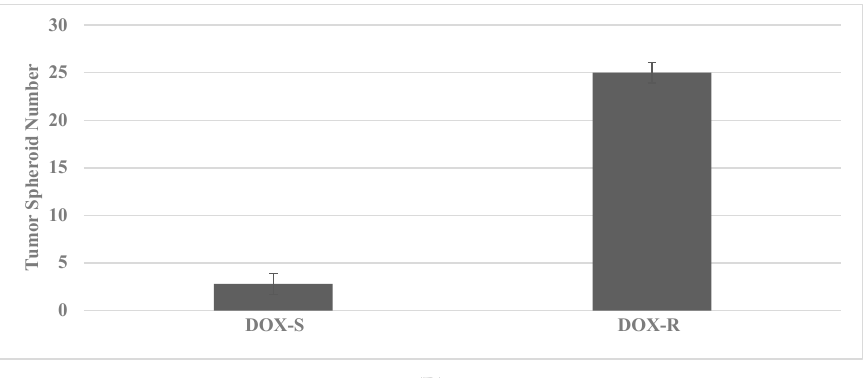
Figure 2. Isolation of drug-resistant putative stem cells in breast cancer models. ( A ) Decreased viable cell number by treatment with TAM in TAM-S cells. EtOH versus TAM p = 0.01. ( B ) Increased tumor spheroid number in TAM-R cells. TAM-S versus TAM-R p = 0.01. ( C ) Decreased viable cell number by treatment with DOX in DOX-S cells. EtOH versus DOX p = 0.01. ( D ) Increased tumor spheroid number in DOX-R cells. DOX-S versus DOX-R p = 0.01. Data analyzed by the two-way Student’s t test. TAM, tamoxifen; TAM-S, TAM sensitive; TAM-R, TAM resistant; EtOH, ethanol; DOX, doxo-